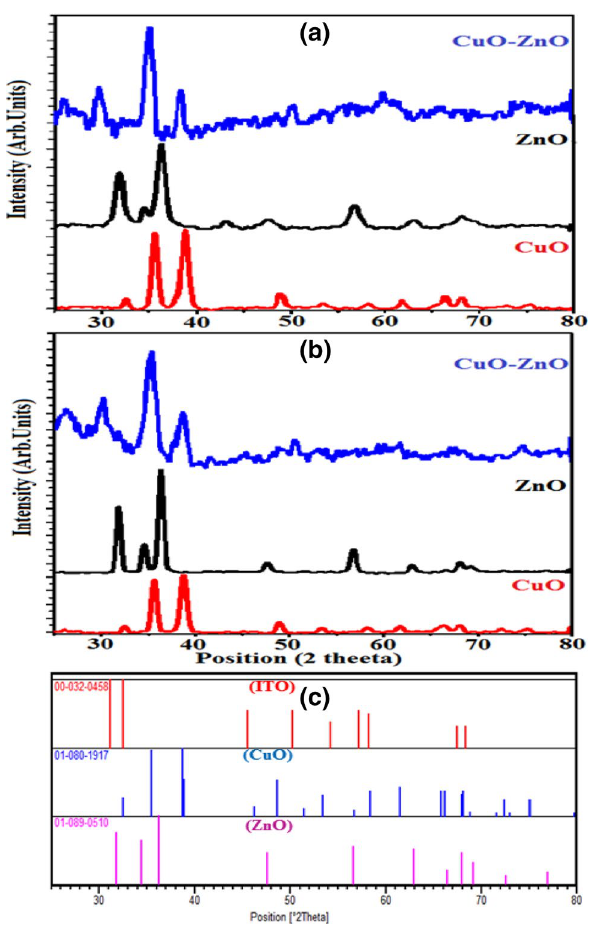
Fig. 2 X-ray diffraction pattern of single and bilayer films at 400 °C ( a ) at 500 °C ( b ) reference patterns ( c )